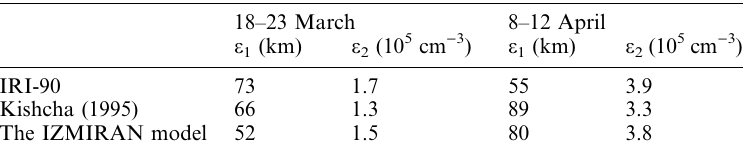
Table 1. Forecasting root-mean-square errors of hmF2 and